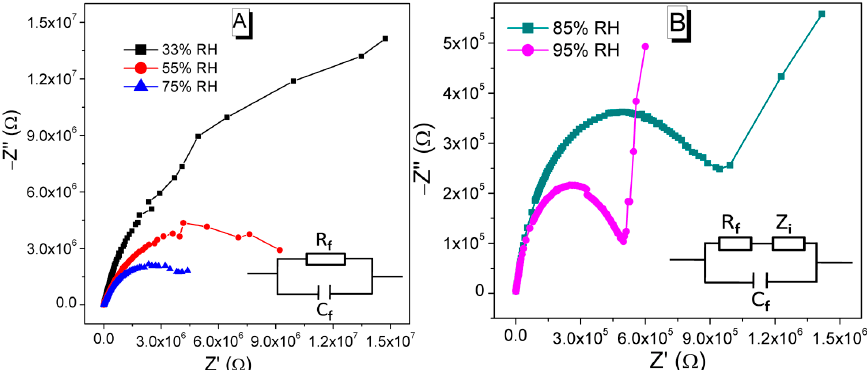
Figure 13. Complex impedance plots and equivalent circuits of CMFTO based electro-ceramic under different humidity levels. ( A ) At lower humidity range (33%–75% RH), single semicircles are formed; the inset represents an equivalent circuit at lower RH; ( B ) At higher humidity condition (85%–95% RH), the radii of semicircle decrease and a straight line appears, and the straight lines become longer with increasing of humidity; the inset represents an equivalent circuit at higher RH. R f and C f : are the resistance and capacitance of CMFTO electro-ceramics, respectively; Z i : interface impedance between CMFTO electro-ceramic surface and electrode .